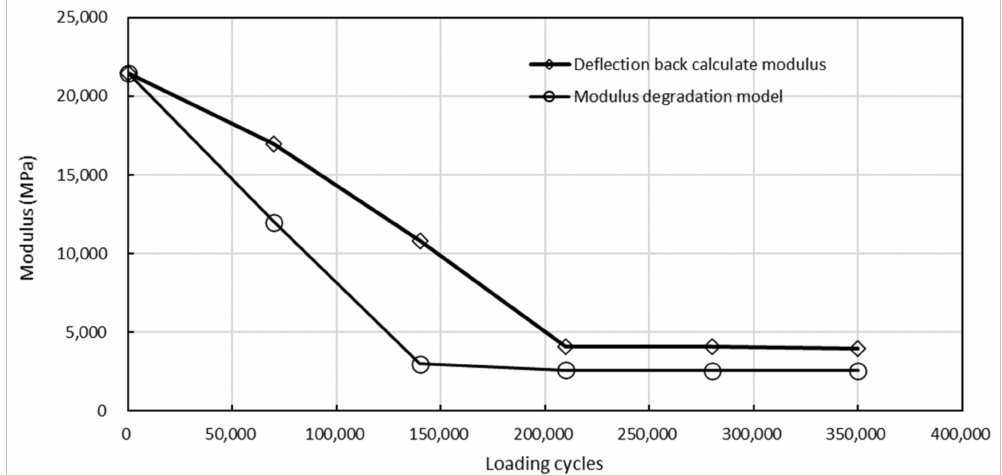
Figure 18. The modulus of deflection back calculation and degradation model in Structure